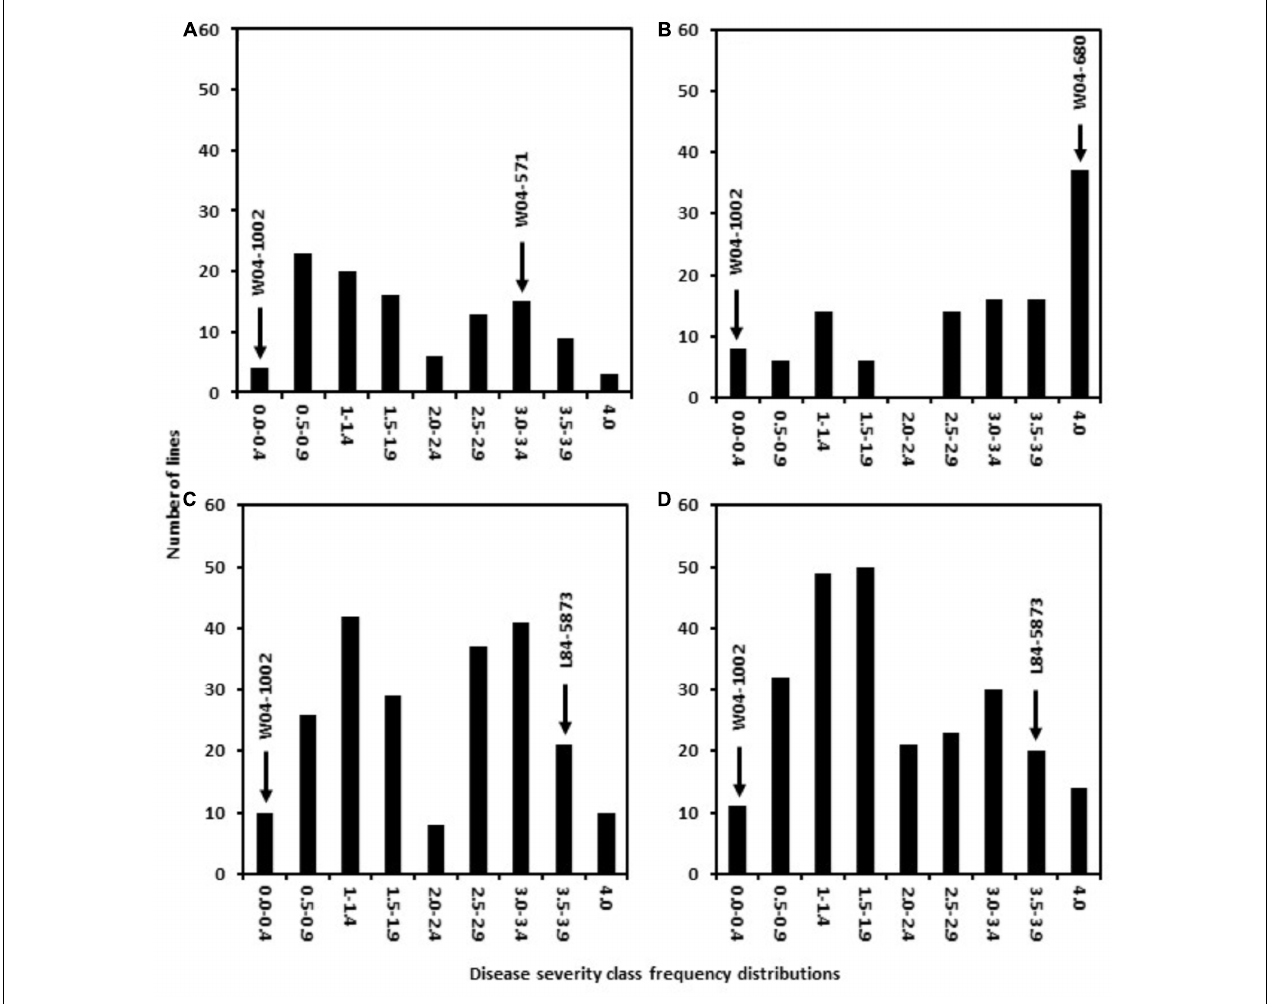
FIGURE 1 | Frequency distribution of disease severity classes in populations 41 (A) , 51 (B) , 81 (C) , and 91 (D) from 2013 greenhouse evaluations. The resistant parent line W04–1002 showed a highly resistant rating of 0.1 while the average rating of other parental lines was 3.0 for W04–571, 4.0 for W04–680, 3.5 for L84–5873, and 3.8 for